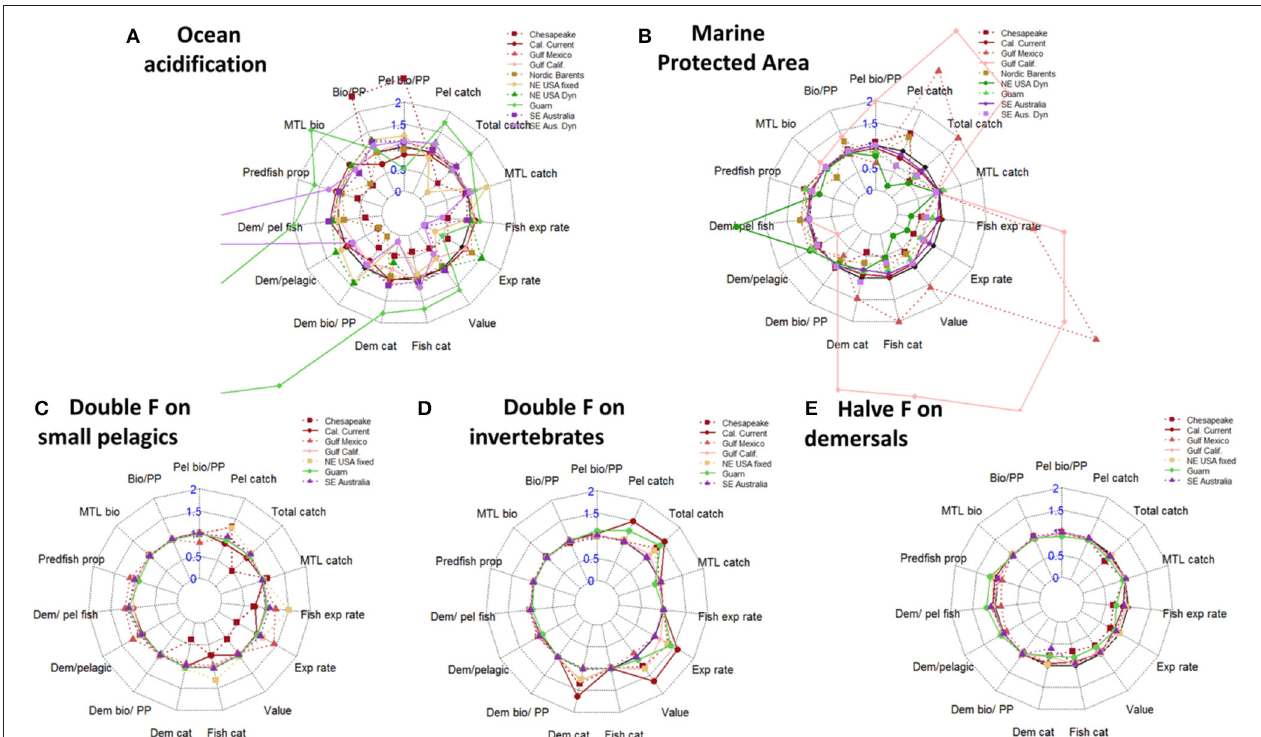
FIGURE 7 | Ecological and fishery indicators for scenarios. Metrics are generally ordered by: Ecological indicators (left), fishery indicators (right), pelagic (top), and demersal (bottom). (A) Ocean acidification, via an additional 1% (day − 1 ) mortality rate added for selected groups. Truncated values: Guam Dem/pelagic = 8.4; SE Aus. Dyn Dem/pel fish = 6.4. (B) Spatial management closing 50% of continental shelf ( < 250m depth) to fishing. (C) Doubling fishing on small pelagic fish. (D) Doubling fishing on invertebrates. (E) Halving fishing rates for demersal